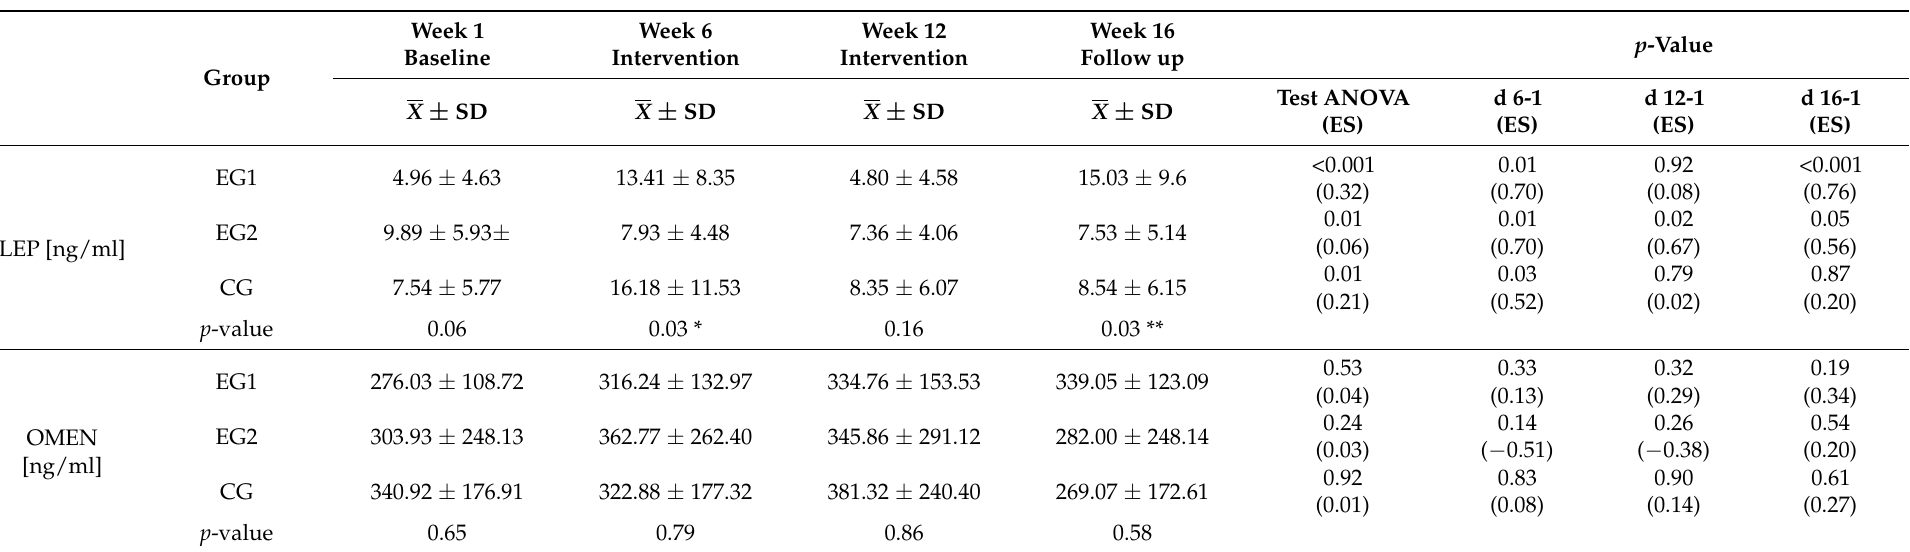
Table 4. Concentrations of leptin (LEP) and omentin (OMEN) in participants’ blood plasma in the aerobic group (EG1), aerobic-resistance group (EG2), and control group